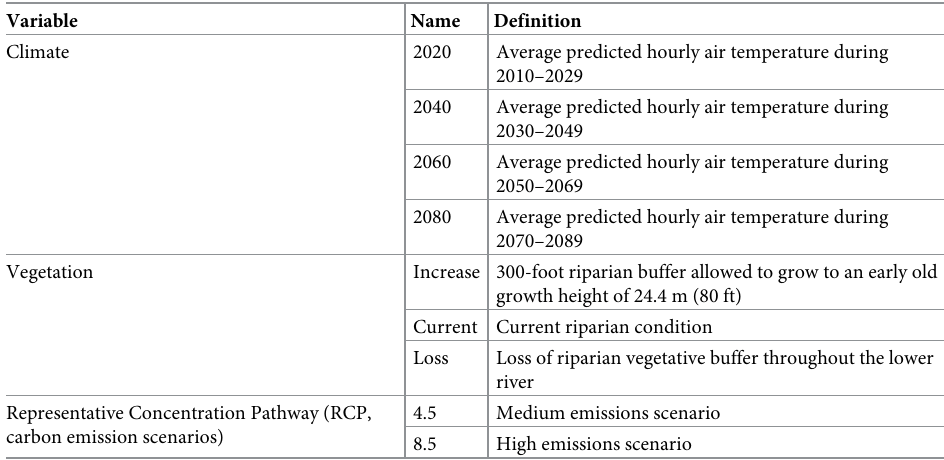
Table 2. Summary of climate and vegetation scenarios.